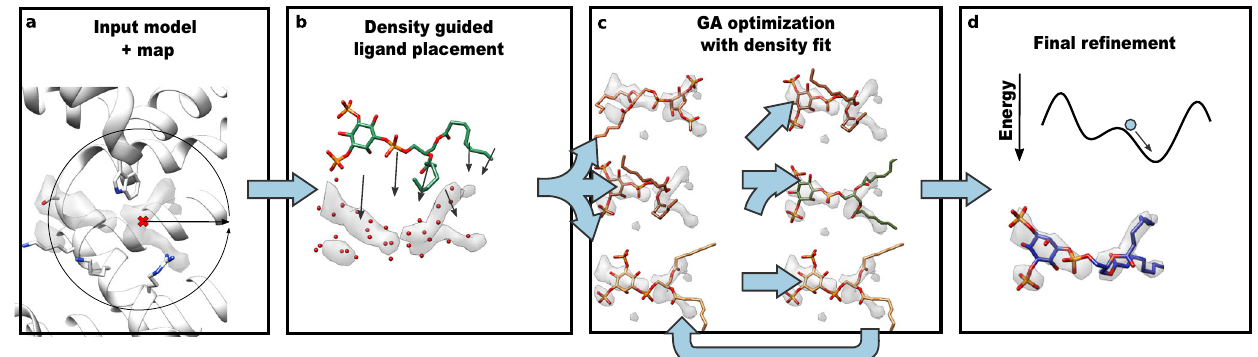
Fig. 1|OverviewofEMERALD docking protocol.a The cryoEMmap,coordinates of the receptor, and the location of the binding site (red cross) are provided as inputs. The binding pocket is calculated depending on the radius of the ligand (circle) to determine boundaries and side chains to consider when modeling. b All unmodeled density in the pocket is converted to a pseudo-atomic skeleton (inde- pendent of ligand identity), which is used to generate an initial set of ligand